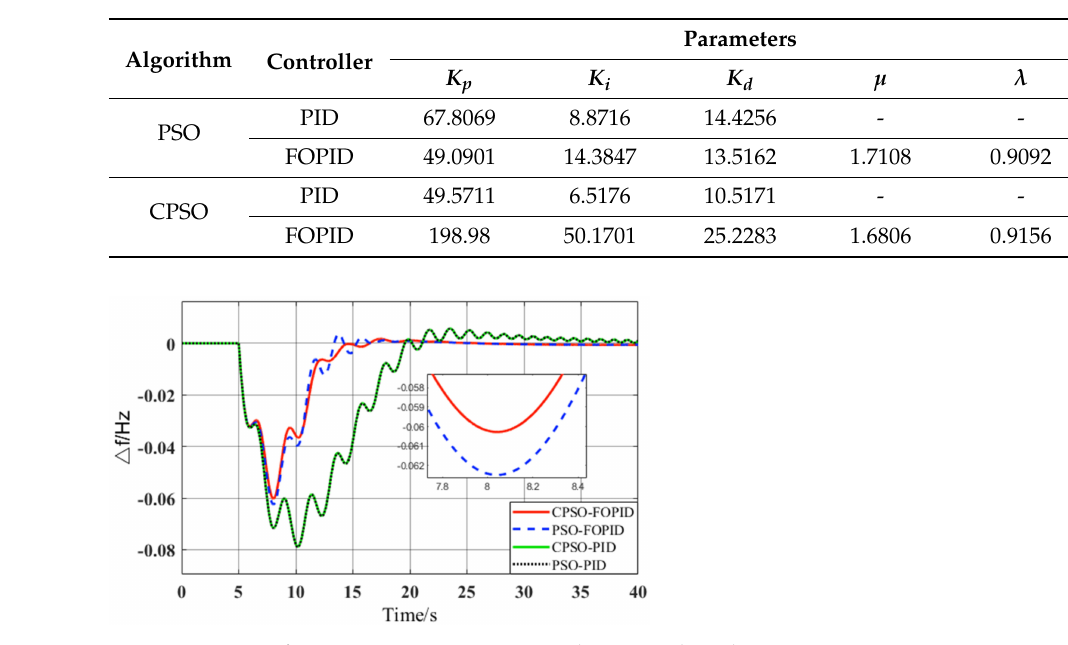
Figure 4. System frequency variation curve under a step